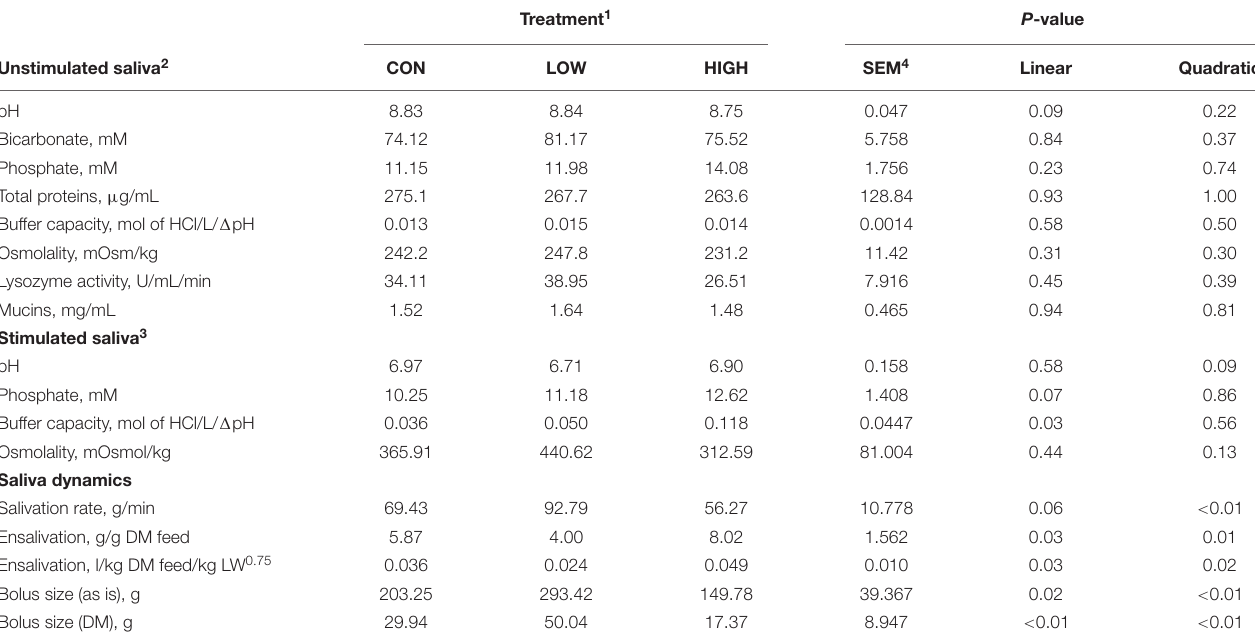
FIGURE 2 | Regression plots illustrating the associations between mucin concentration and bicarbonate ( secretions of cattle, plots include average values across angelica root, garlic oil, and thyme oil. TABLE 3 | Effect of supplementation with capsaicin on salivary physico-chemical properties, salivation, and feed bolus dynamics of non-lactating Holstein dairy cows.